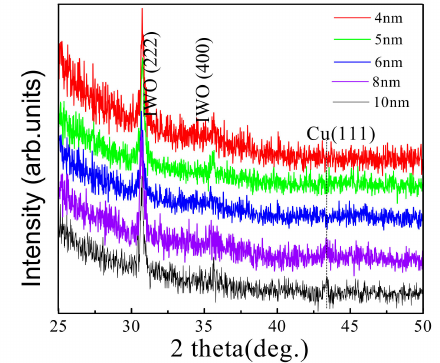
Figure 3. XRD patterns of five IWO / Cu / IWO films on quartz substrates. The thicknesses of the intermediate Cu are 4, 5, 6, 8, and 10 nm, respectively. The IWO film has an unchanged thickness of 40